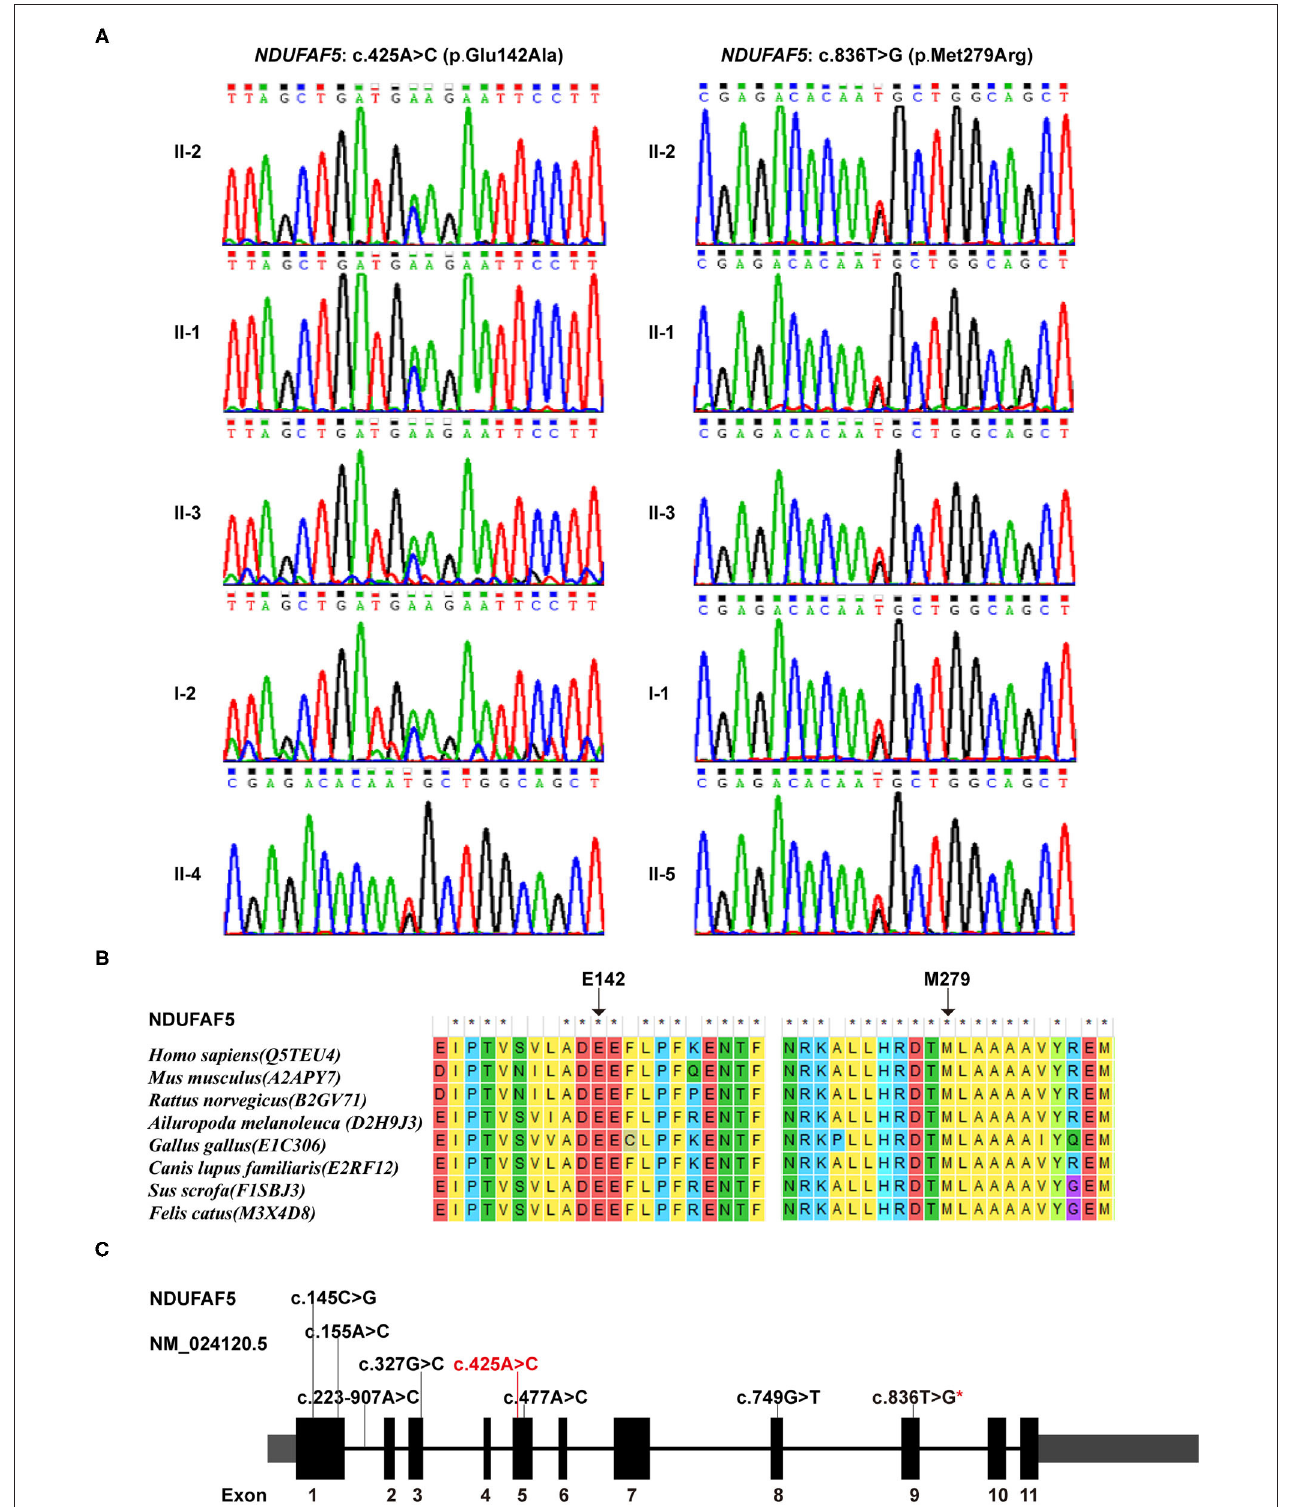
FIGURE 3 | Genetic findings in this study. (A) Sequence variants and carrying status of each member in this family. (B) Conservatism of the 2 corresponding amino acids of the 2 missense variants among species. (C) The identified variants in NDUFAF5 gene so far (Red characters represented the variant identified in this study; red star means the one identified both in this study and in other